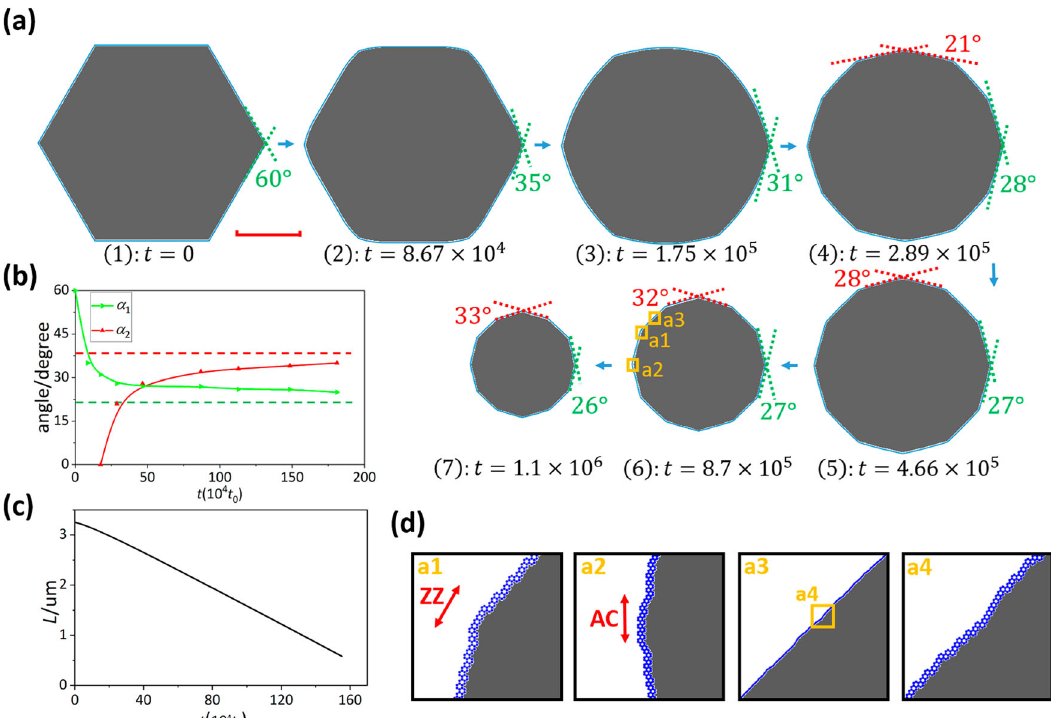
Fig. 4 Etching of a graphene island. The simulation condition is μ = − 0.2 eV and k B T = 0.1 eV. a Representative snapshots of a trajectory of KMC simulation for graphene etching. After dodecagon formed, the angles α 1 (green) and α 2 (red) are measured. The scale bar is 1 μ m for all snapshots. b Plot of α 1 and α 2 along with etching time. The dash lines correspond to the 19° edges. c Plot of the island size in a with growth time. d Atomic details during the simulation, where a1 and a2 are corners between adjacent edges, a3 and a4 are edge with high kink